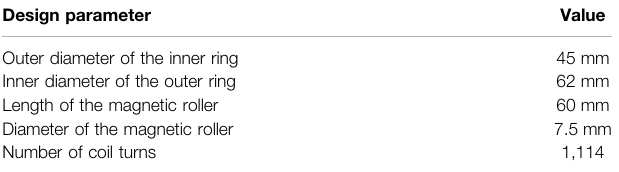
TABLE 1 | Main parameters of the planetary MRTD.